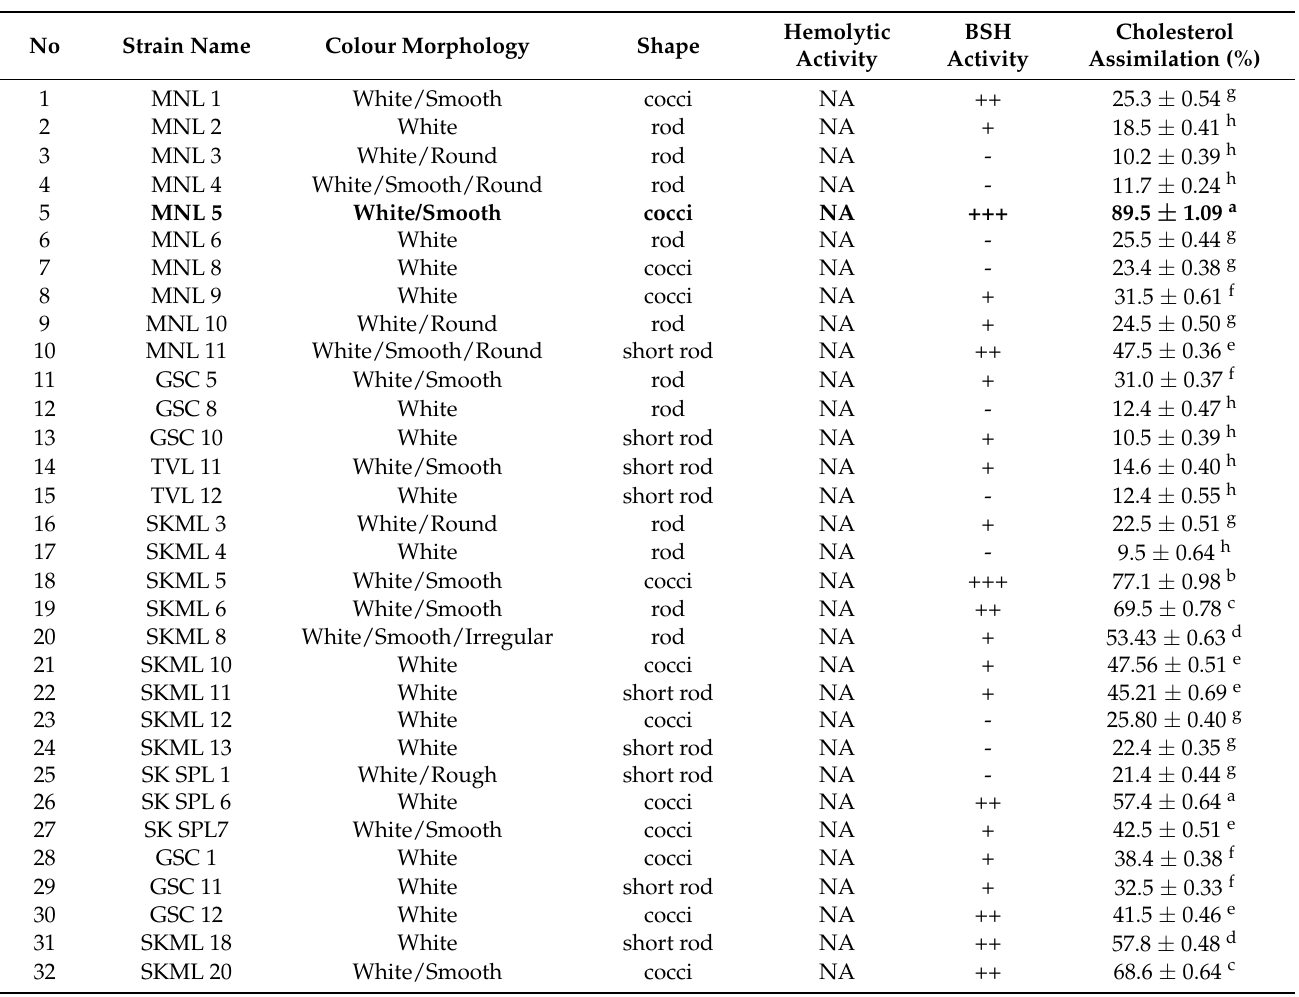
Table 1. Assimilation of cholesterol, Haemolytic activity and BSH of isolated LAB strains from fermented herbal